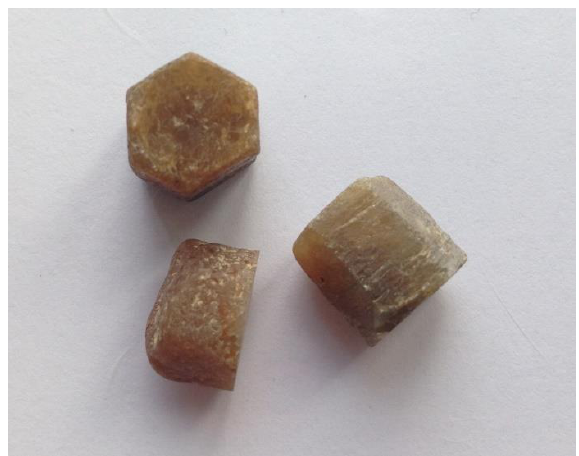
Figure 1. Yellow sapphires from unknown mining areas in